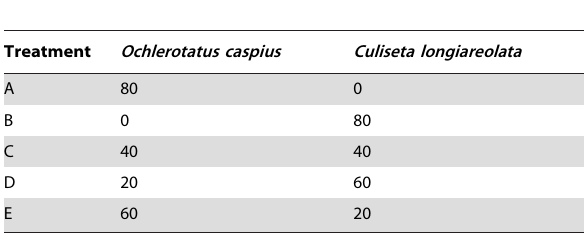
Table 1. Initial abundance combinations of 1 st instar larvae, each having six